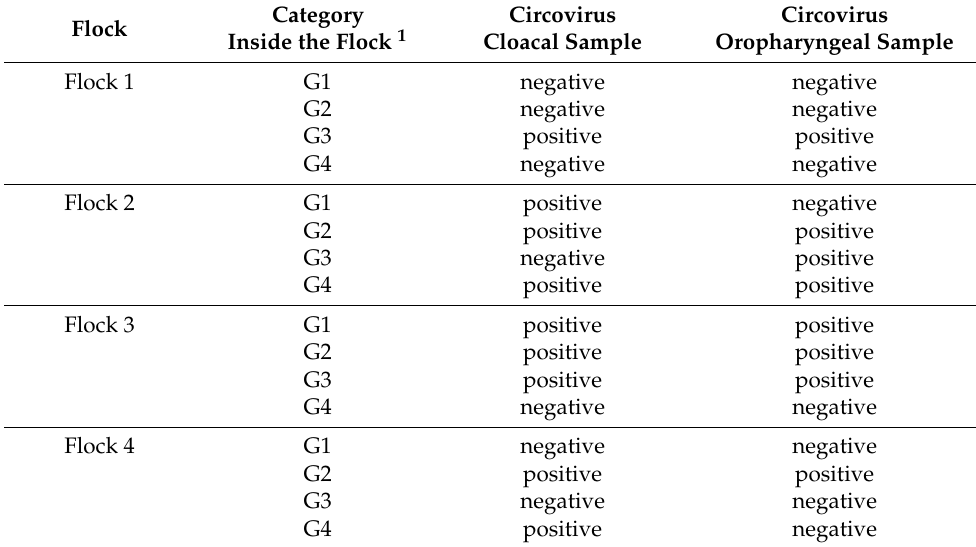
Table 1. The presence of PiCV in individual flocks and categories. Category Flock Inside the Flock 1